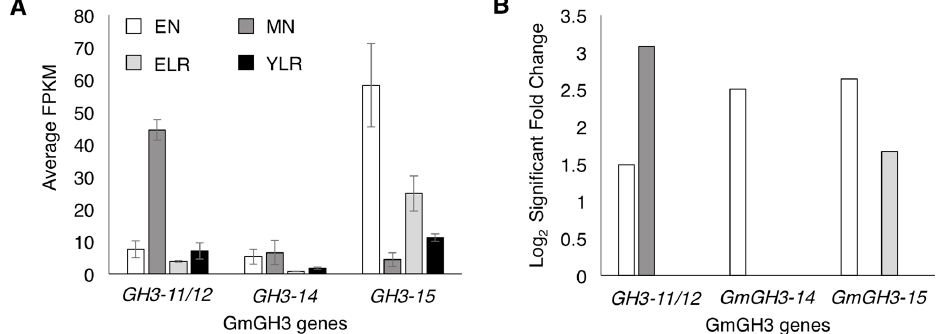
Figure 1. Expression of GmGH3 genes in soybean root lateral organs. ( A ) Expression levels of GmGH3s in emerging nodule (EN), mature nodule (MN), emerging lateral root (ELR), and young lateral root (YLR) tissues. Data shown are average expression values from three biological replicates obtained using RNA-seq. Normalized gene expression levels based on RNA-seq read counts are shown in FPKM (fragments per kilobase of transcript per million mapped reads). Error bars indicate SD; ( B ) Enrichment of GmGH3 gene expression in the same four tissue types relative to adjacent root tissues. Data shown are statistically significant log 2 fold change values vs. the respective control root segments from three biological replicates. See Table S1 for additional details.